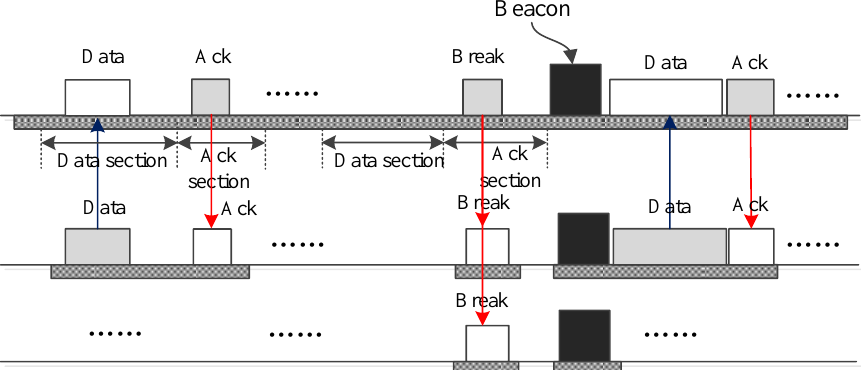
Figure 9. The case that a break is postponed.